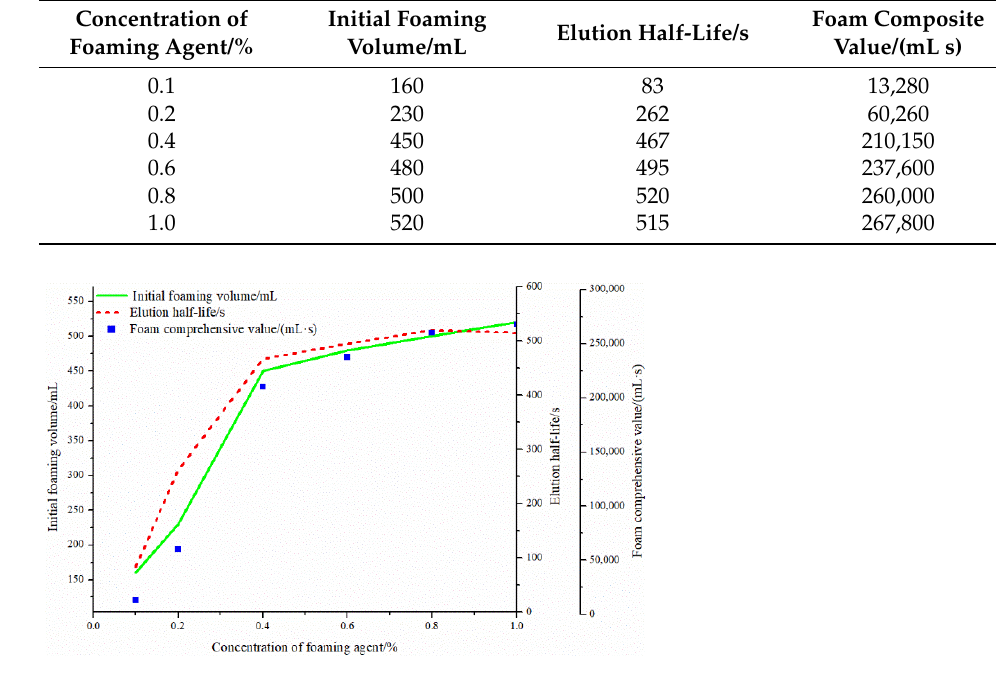
Table 3. Foam comprehensive coefficient under varying concentrations of foaming agent.